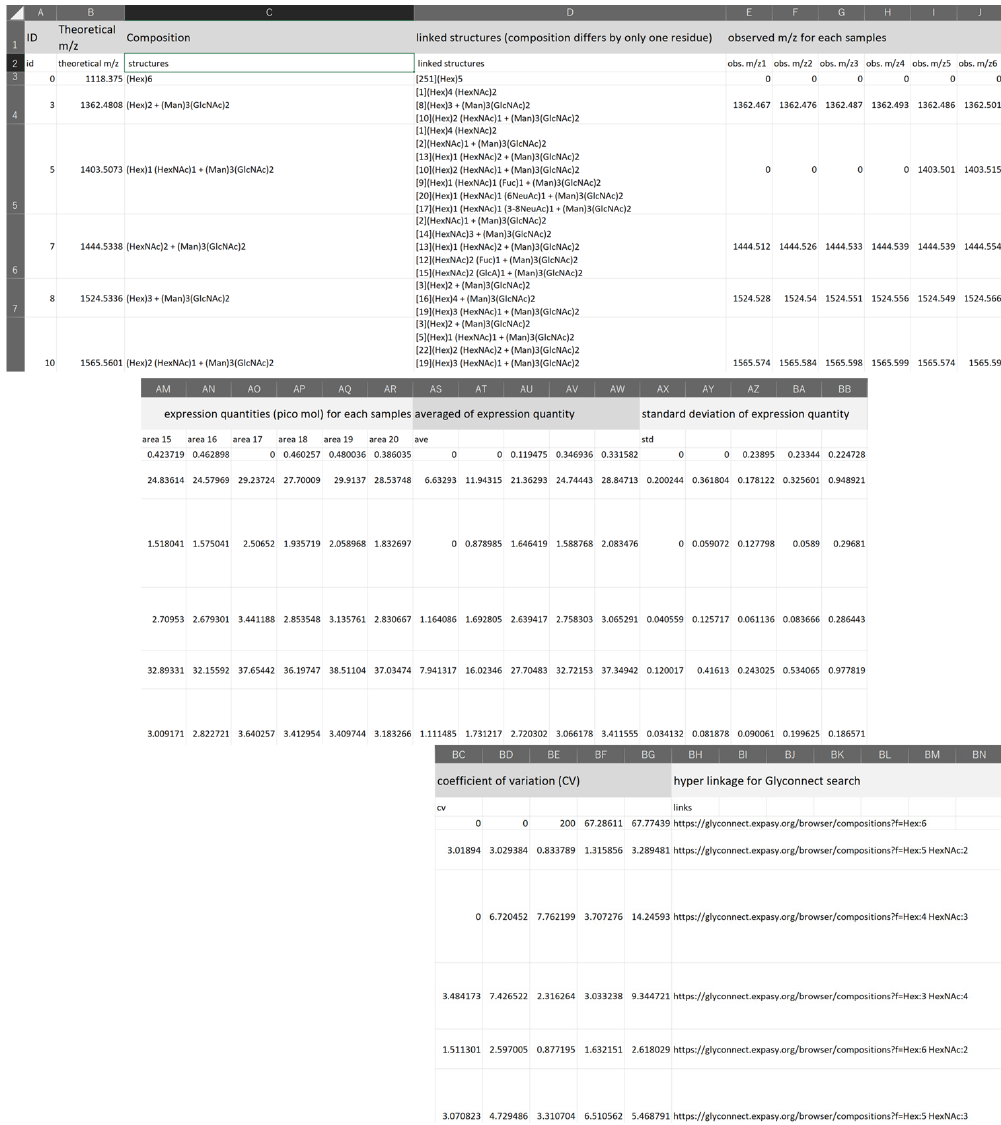
Figure 4. Screenshot of a part of the summary file. Table 3. New output files for the updated TAG Express. All output files are shown in Table